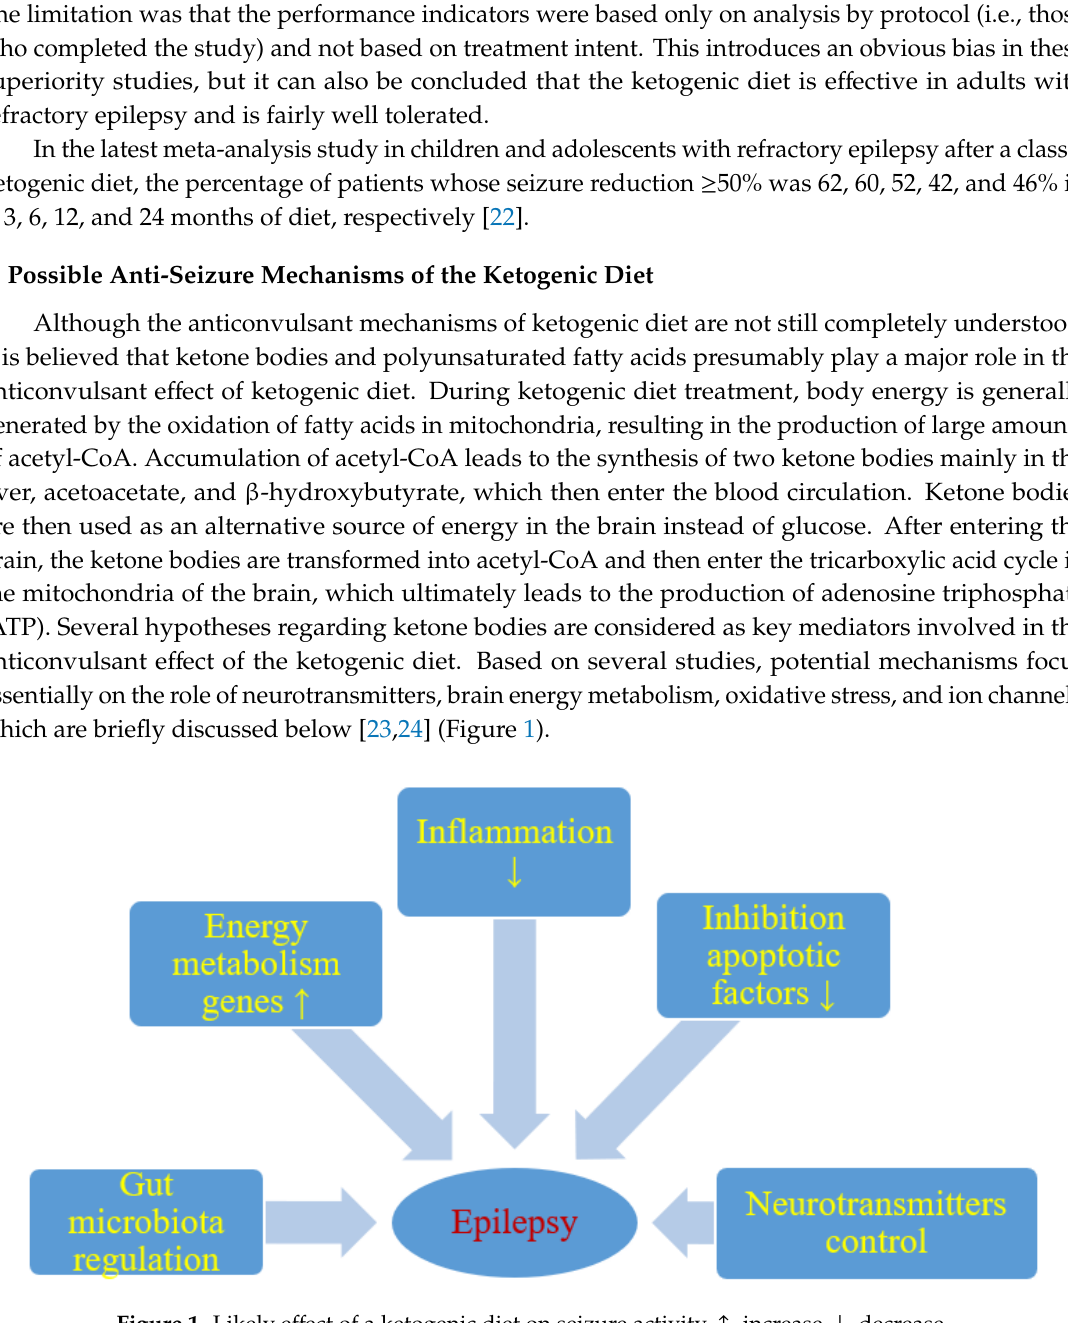
Figure 1. Likely e ff ect of a ketogenic diet on seizure activity. ↑ - increase, ↓ - Figure 1. Likely effect of a ketogenic diet on seizure activity. ↑ - increase, ↓ - decrease.